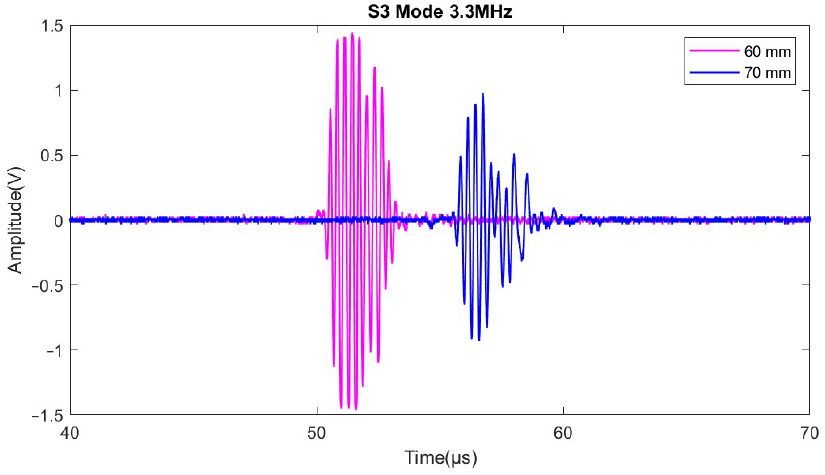
Figure 5. Amplitudes with respect to propagation distance on bonded zone